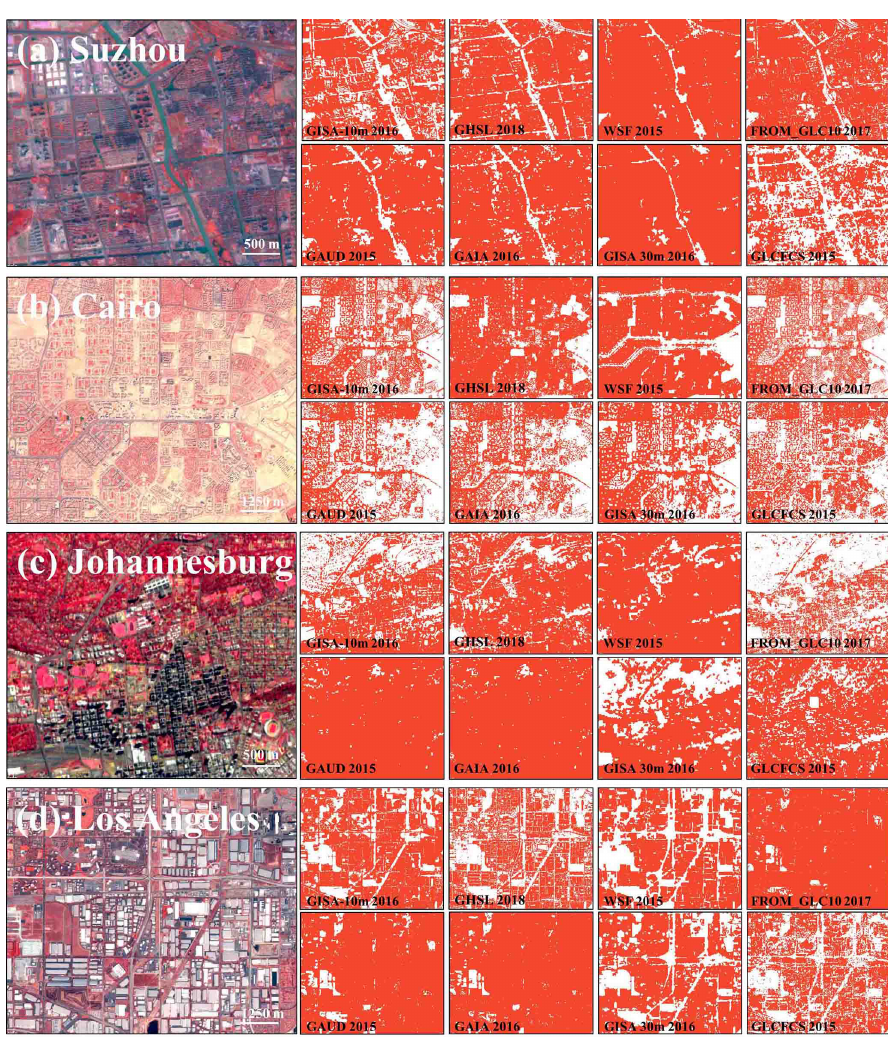
Figure 10. Comparison between GISA-10m and the seven datasets over urban regions in (a) Suzhou, China; (b) Cairo, Egypt; (c) Johan- nesburg, South Africa; and (d) Los Angeles, US. The Sentinel-2 images were composited in a false-color combination (R: NIR, G: red, B: